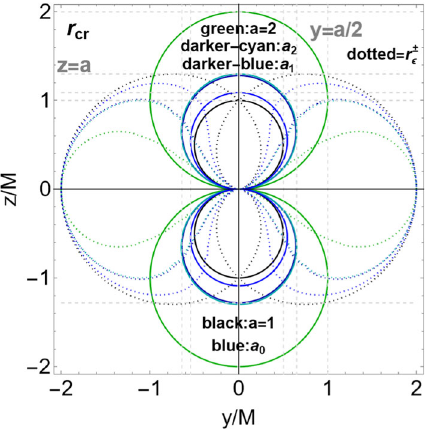
(cid:6) Fig. 15 Radius r cr ofEq.(10),intheplane ( y , z ) where r = z 2 + y 2 ±√ z ( ∓ a − z ) and and σ ≡ sin 2 θ = y 2 /( z 2 + y 2 ) . It is y = (cid:19) (cid:18) (cid:6) ± a 2 − 4 y 2 + a z = ± 1 , for different spins signed on the pan- 2 els. Dashed gray lines are y = a / 2 and z = a . Radii r ± (cid:11) are the outer and inner ergosurfaces. Notation ( mso , mbo ,γ) refers the marginally stable, marginally bounded and last circular orbit respectively